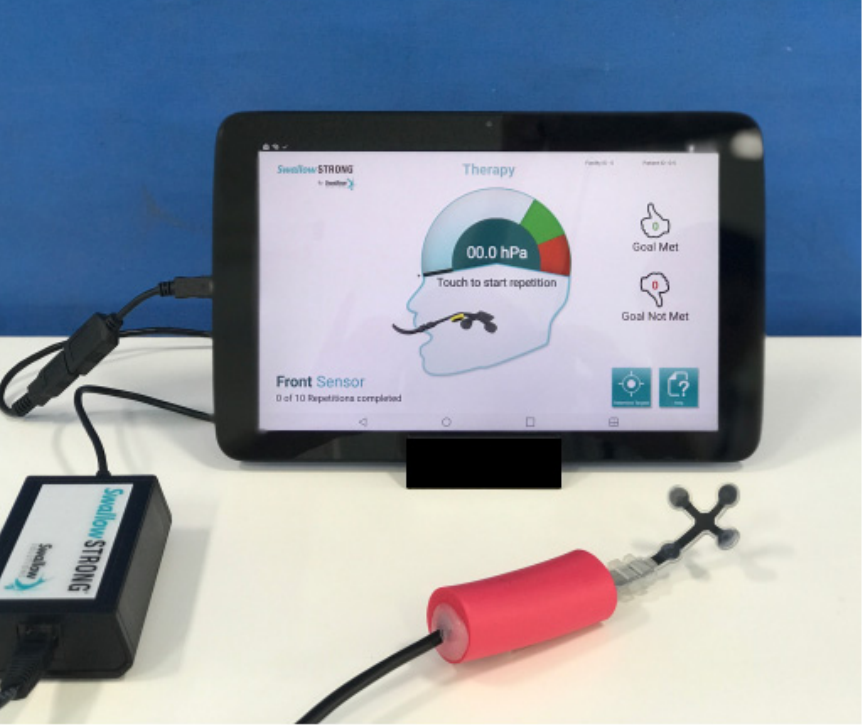
Figure 4. The Swallow STRengthening OropharyNGeal (Swallow STRONG). The device consists of custom-molded mouthpiece measuring tongue pressure and the tablet providing visual feedback.